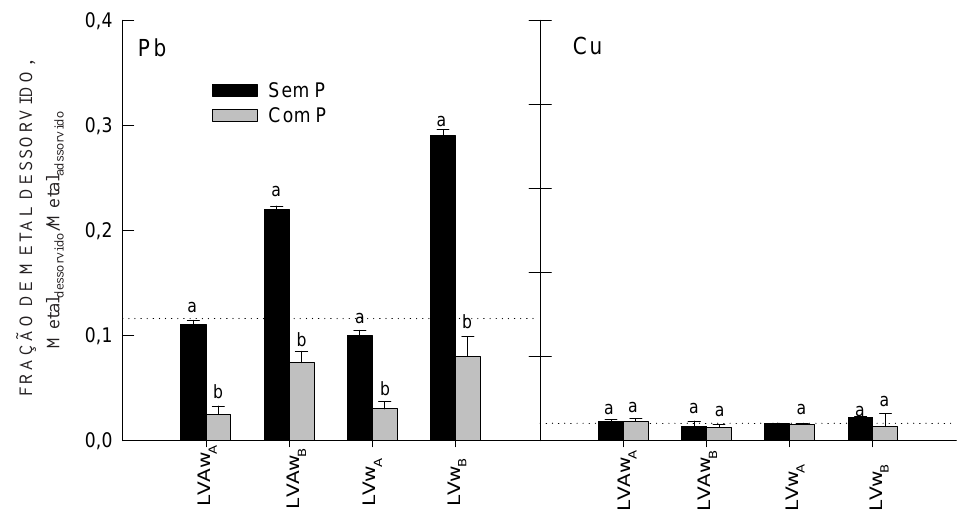
Figura 2. Fração dessorvida (Metal de amostras de Latossolos, tratadas e não tratadas com fósforo, submetidas previamente à adsorção, individualmente, de Cd(NO Amarelo ácrico típico; LVw = Latossolo Vermelho ácrico típico; os índices A e B indicam os horizontes e P as amostras tratadas com fósforo). Colunas seguidas da mesma letra, para um mesmo solo, não diferem entre si pelo teste de Scott-Knott a 5 %. Barras acima das colunas indicam o erro-padrão da média (n = 3) e a linha pontilhada representa a fração dessorvida